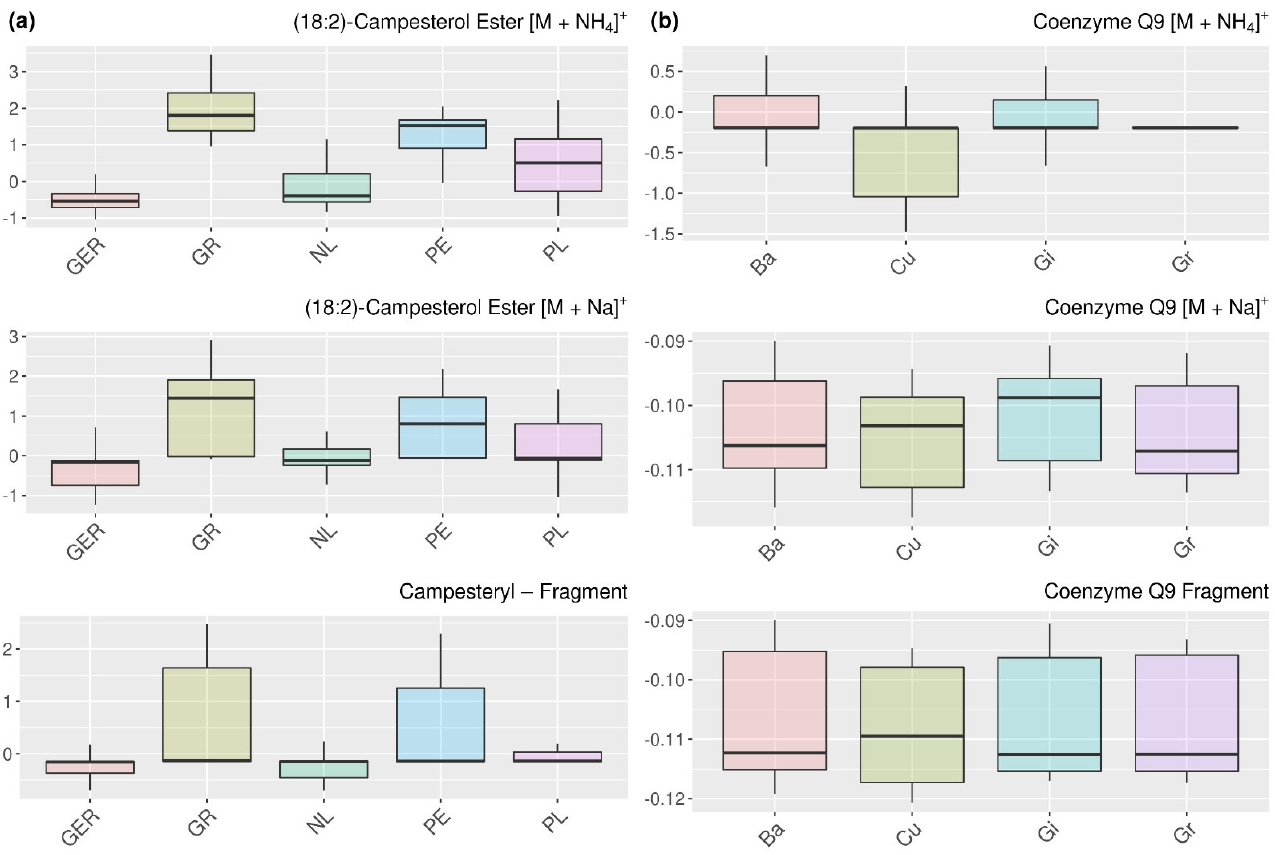
Figure 6. Comparison of features with very high pairwise mean adjusted agreement values that could be assigned to the same metabolites. Features of campesterol ester for the relation analysis regarding the determination of geographical origin ( a ) and features of coenzyme Q9 for the botanical variety ( b ) are shown. Detailed information about the metabolites can be obtained from Table S7.